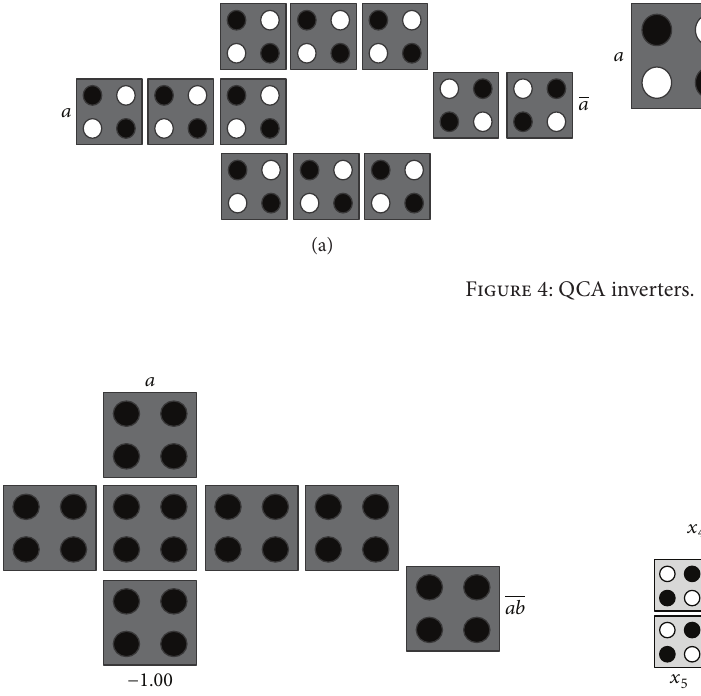
Figure 5: QCA layout of NAND gate.